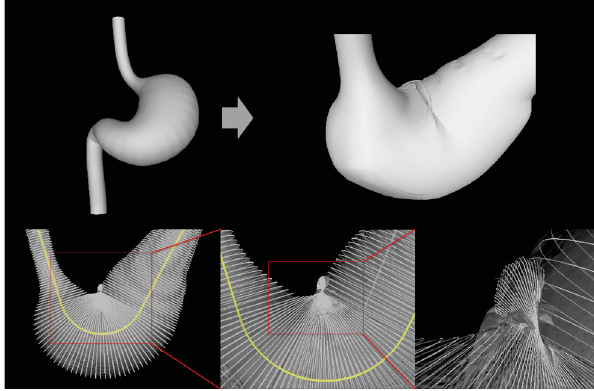
Fig. 18 Above: a human stomach mesh is bent through 135 ◦ which leads to surface folding. Below: close-ups of the problematic region after deformation. Cross sections: white, centerline: